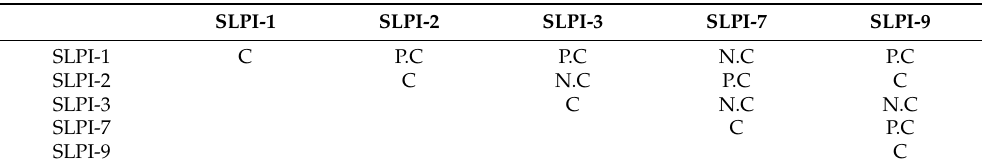
Table 3. Non-competitive Nb pair possibilities for SLPI (C—competitive; P.C—partially competitive; N.C—non-competitive).